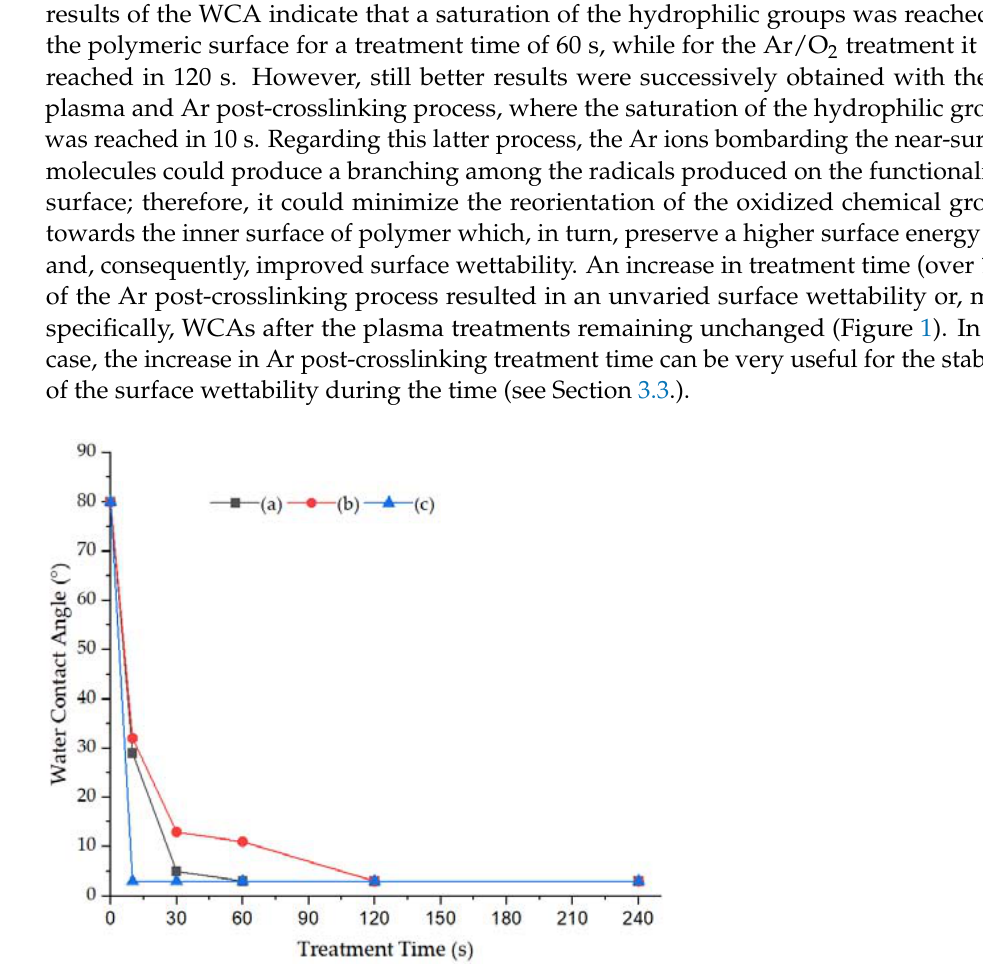
Figure 1. Water contact angle of treated PBS substrates in terms of the treatment time with (a) pure O 2 plasma, (b) Ar/O 2 plasma, and (c) O 2 plasma 30 s + Ar post-crosslinking for 120 s.